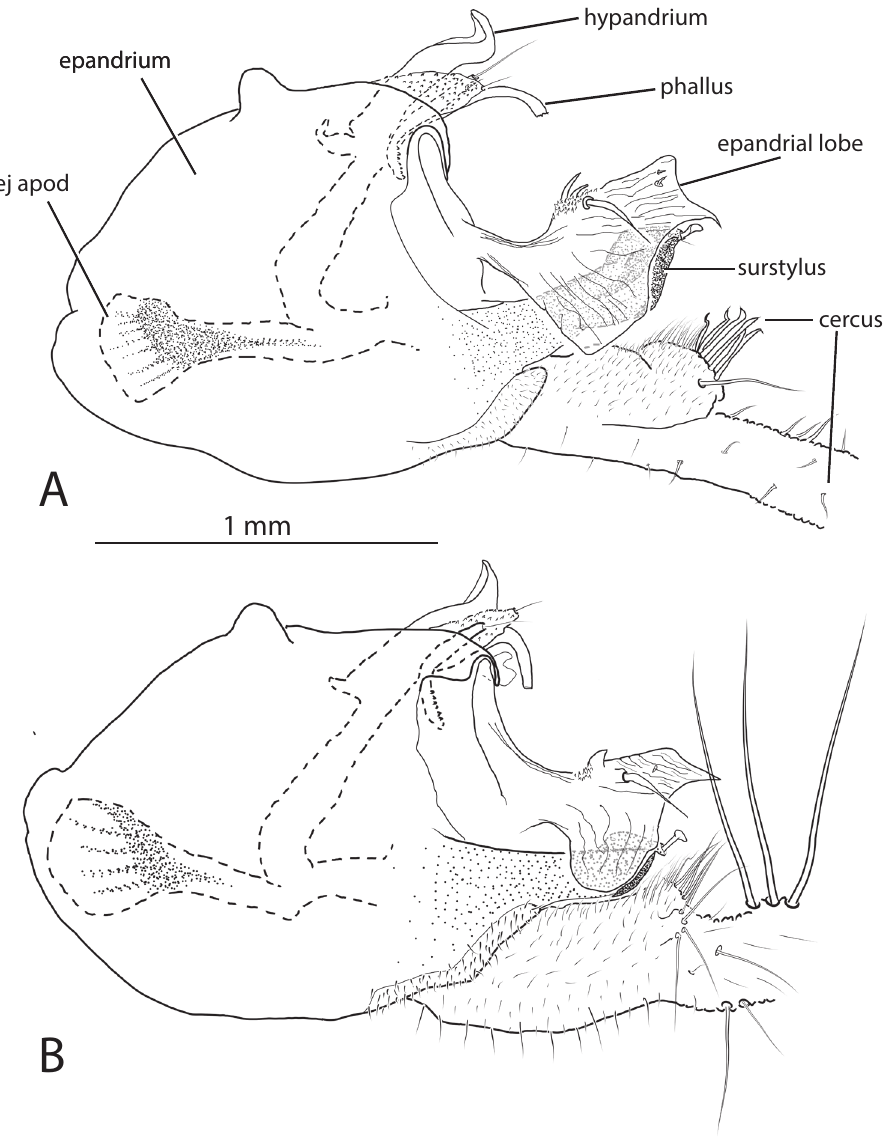
Figure 11. Liancalus male terminalia, right lateral view of A L. pterodactyl sp. n., and B L. hydrophilus Aldrich. ej apod = ejaculatory apodeme. Scale bar = 1 mm. Only base of cercus shown, see Figures 2D and 8 for photographs of entire